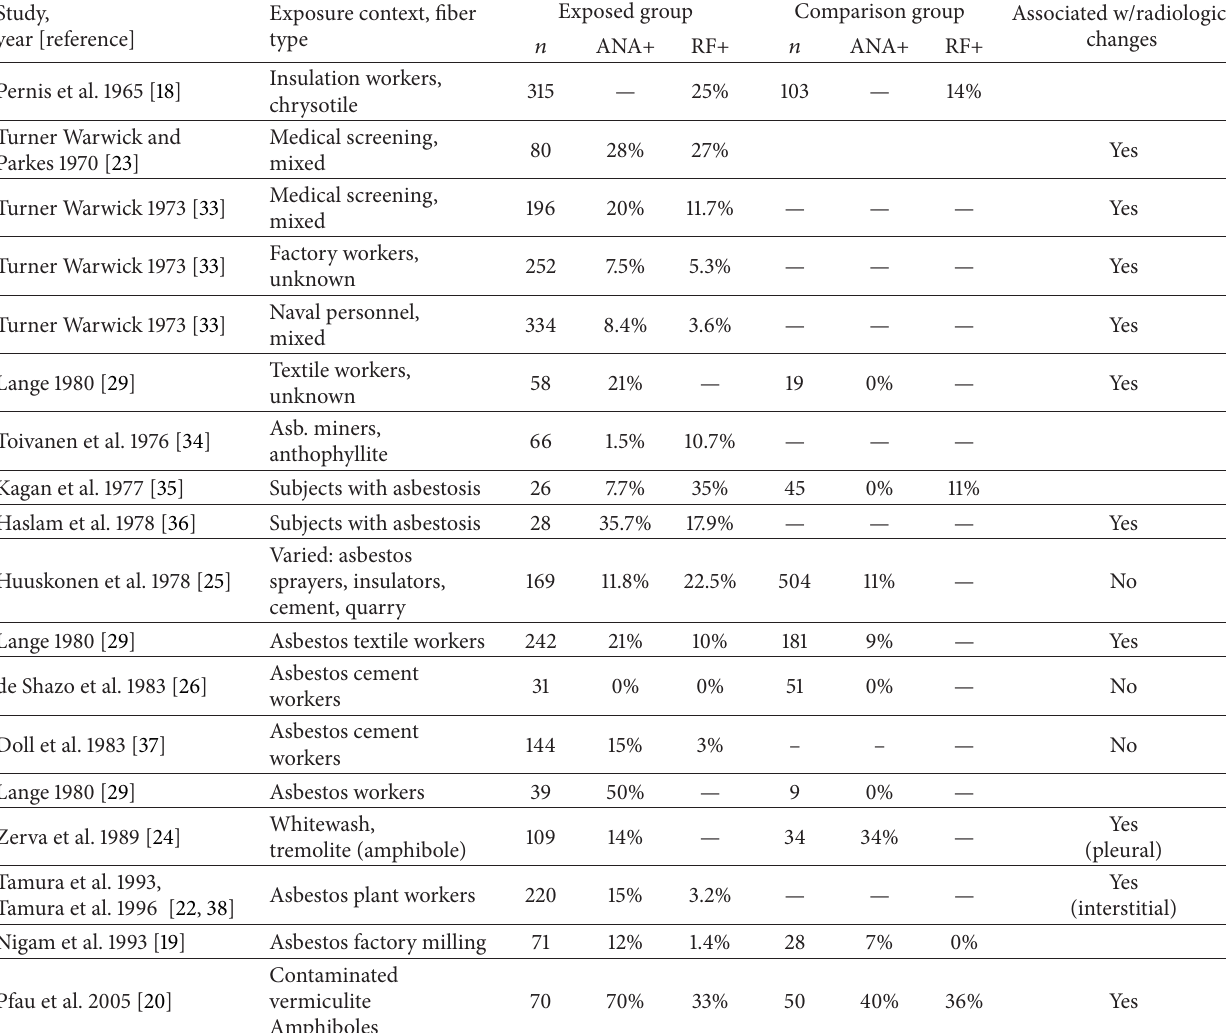
Table 2: Selected studies evaluating antinuclear antibodies (ANA) and rheumatoid factor (RF) among asbestos exposed subjects.